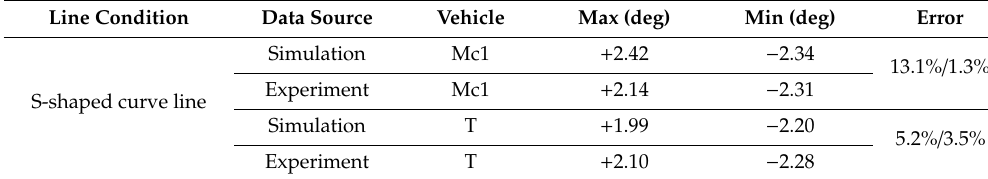
Table 5. Difference between the experimental results and the simulation results, (S-shaped curve line). Line Condition